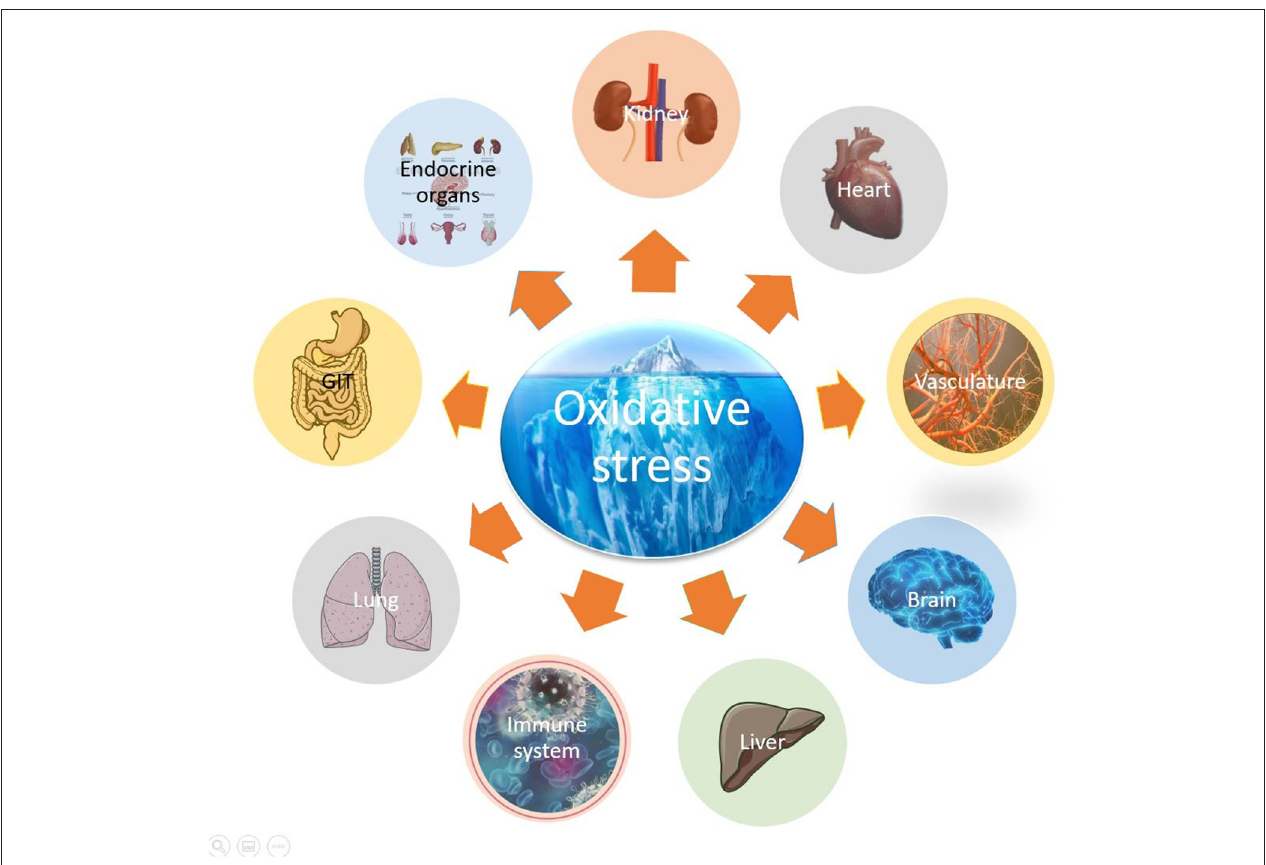
FIGURE 1 | Oxidative stress as an underlying cause of multiple organ